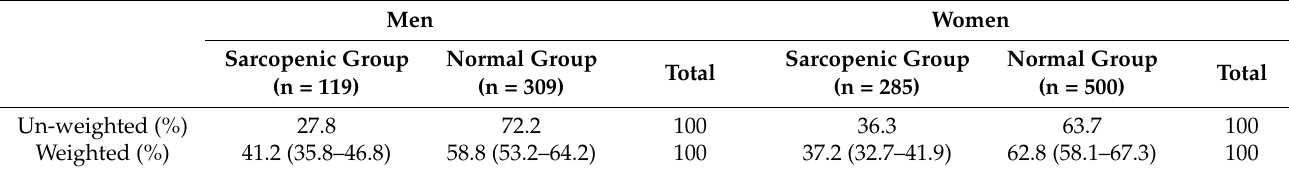
Table 2. Prevalence of sarcopenia according to gender.